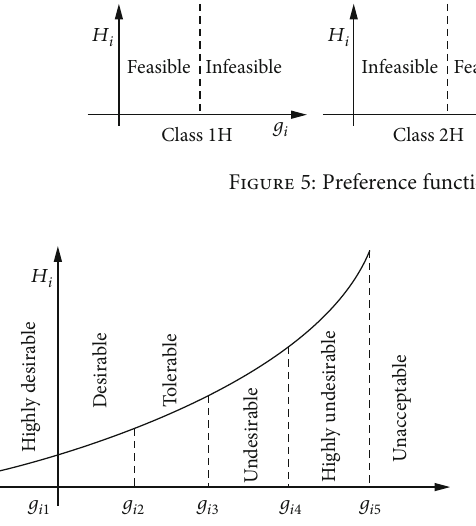
Figure 6: Preference function regions for Class